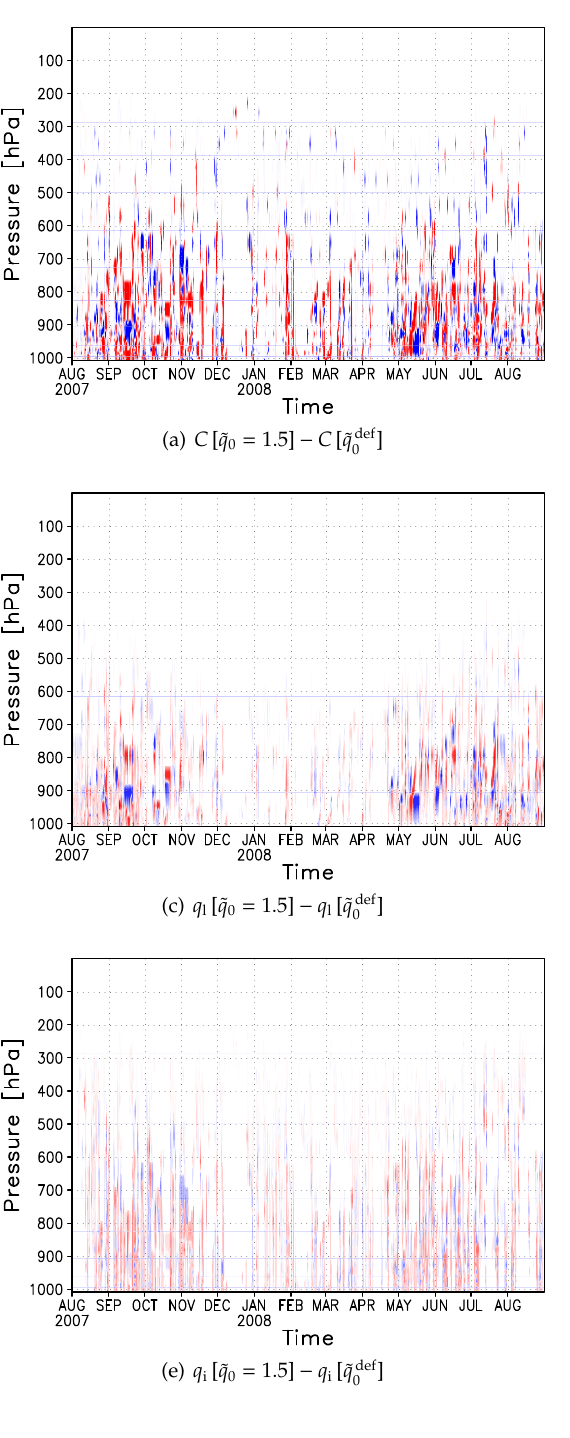
Figure 5. Difference plots (SENS minus CTRL) of simulated fractional cloud cover ( top ), cloud water content ( middle ), and cloud ice content ( bottom ) for one lower value of the PS-Scheme adjustment parameter ˜ q ( left column ) and one higher value of the tunable 0 = 2 and CW def = 0 . 1 mg kg − 1 parameter CW ( right column ), with ˜ q def min 0 min